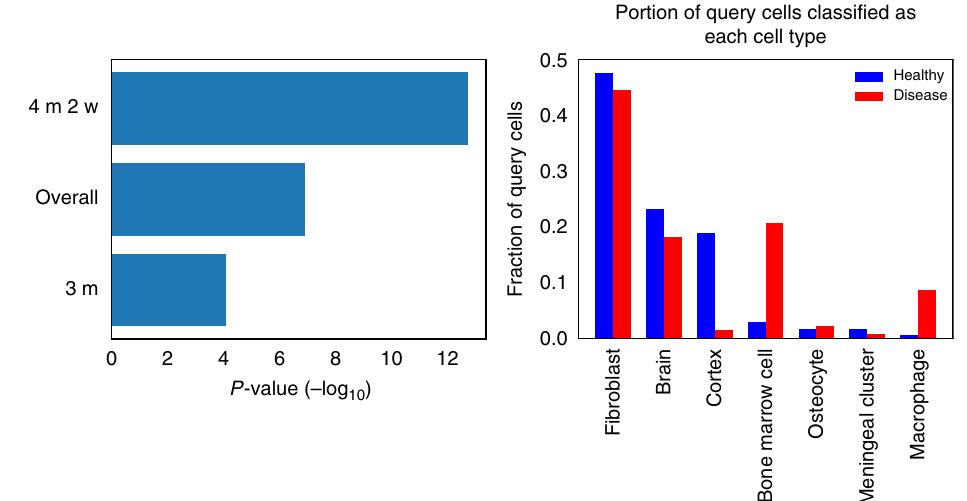
Fig. 4 Analysis of mouse neurodegeneration dataset, late-response cells. a p -Values of the difference in cell-type classi fi cation distributions (healthy vs. disease cells) for different time points. Three months was the initial time point in the study, and 4 months 2 weeks was the last time point. “ Overall ” is the pool of all 1990 cells. The p -values are from conducting Fisher ’ s exact test (for “ overall ” , the p -value was simulated based on 1×10 7 replicates). b Classi fi cation distribution for late-stage cells (4 months 2 weeks), showing an increase in immune-related cell types in the disease cell